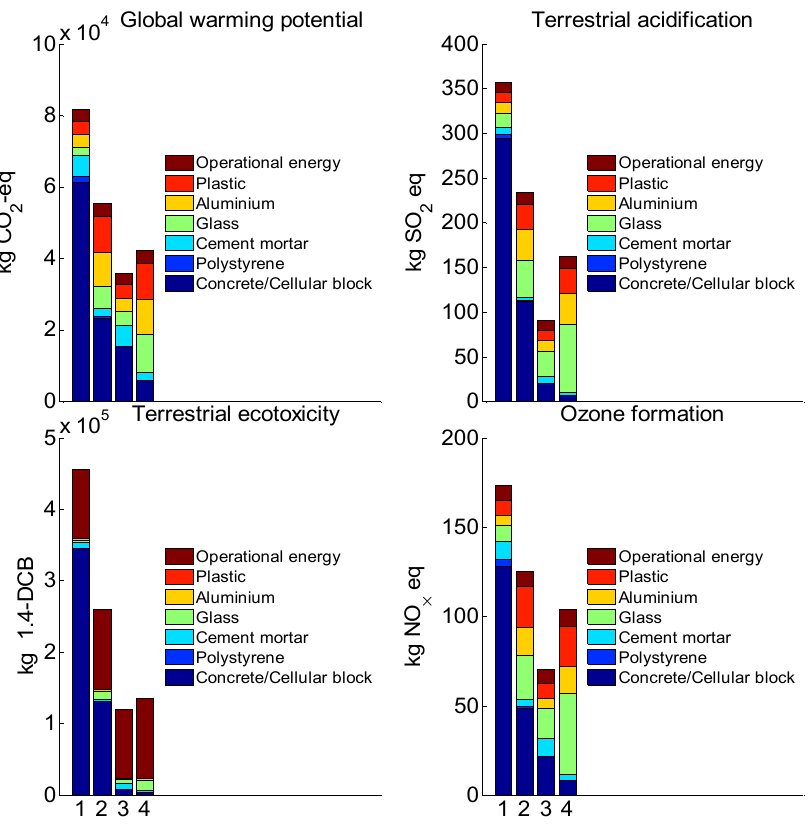
Figure 6. P&R and OE stages (OE stage with 100% PV-based electricity): environmental impact of CB MinWin (1), CB MaxWin (2), AAB MinWin (3), and AAB MaxWin (4), evaluated with ReCiPe2016 midpoint method, hierarchist (H) methodological option.